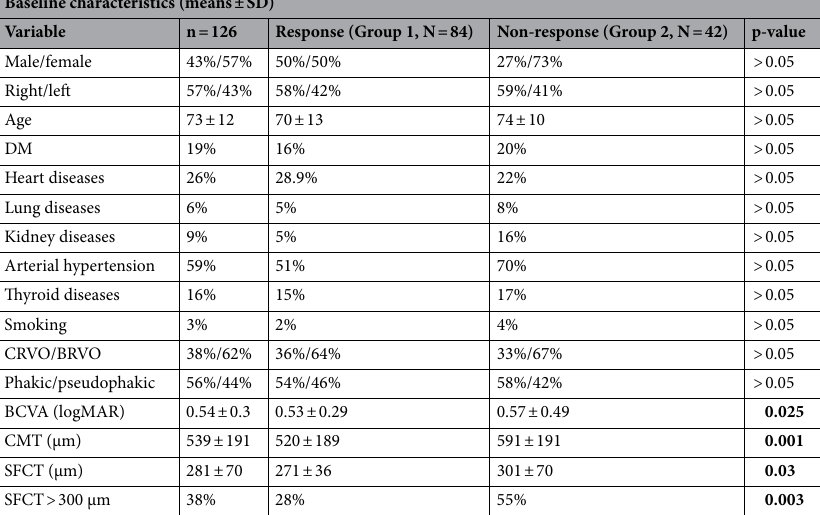
Table 1. The baseline characteristics of study eyes and both groups. Significant values are in bold. Group 1 (response group, n = 84): eyes that showed a therapeutic response to intravitreal bevacizumab. Group 2 (non- response group, n = 42): eyes that did not show a therapeutic response to intravitreal bevacizumab. SD standard deviation, DM diabetes mellitus, BCVA best-corrected visual acuity, CMT central macular thickness, SFCT subfoveal choroidal thickness, CRVO central retinal vein occlusion, BRVO branch retinal vein occlusion.